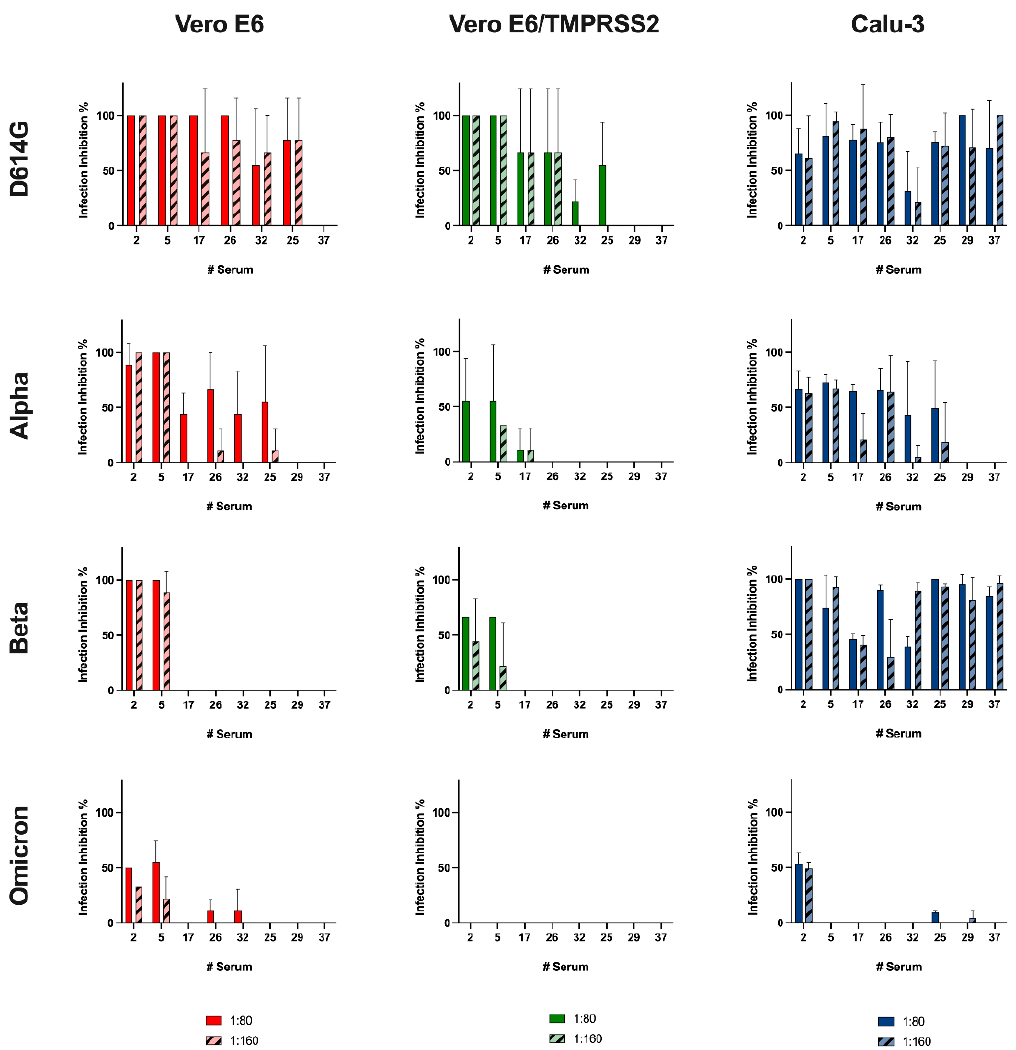
Figure 5. Neutralization assay using the different cell lines. Neutralization activity was assessed using two sera dilutions (1:80 and 1:160) against 0.01 MOI of four SARS-CoV-2 variants: D614G, Alpha, Beta and Omicron. Sera were incubated with the virus dilutions 1 h before the infection. CPE was assessed after 72 h, and the cell supernatants were collected. Each condition was tested in triplicate, and data were normalized over controls. The infection inhibition percentages were reported as the mean values ± SD.